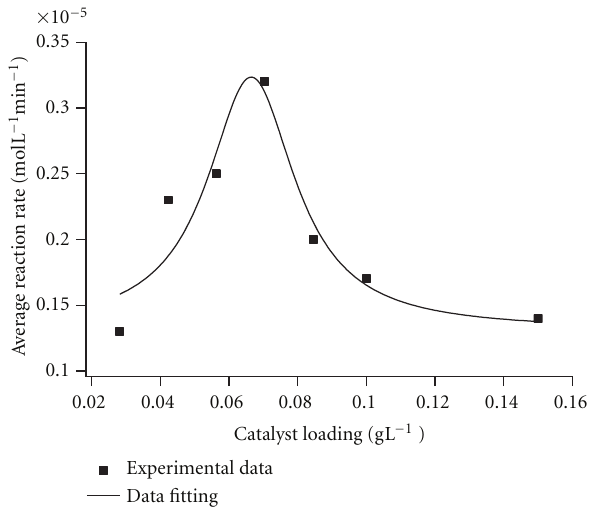
Figure 5: E ff ect of catalyst loading on average reaction rate (TOC initial concentration = 24 . 62 ± 0 . 44mgL − 1 , average reaction temperature = 27 ◦ C, initial slurry pH = 3 . 00, 1.8 Lmin − 1 air flow rate and 4.4Lmin − 1 slurry flow rate).